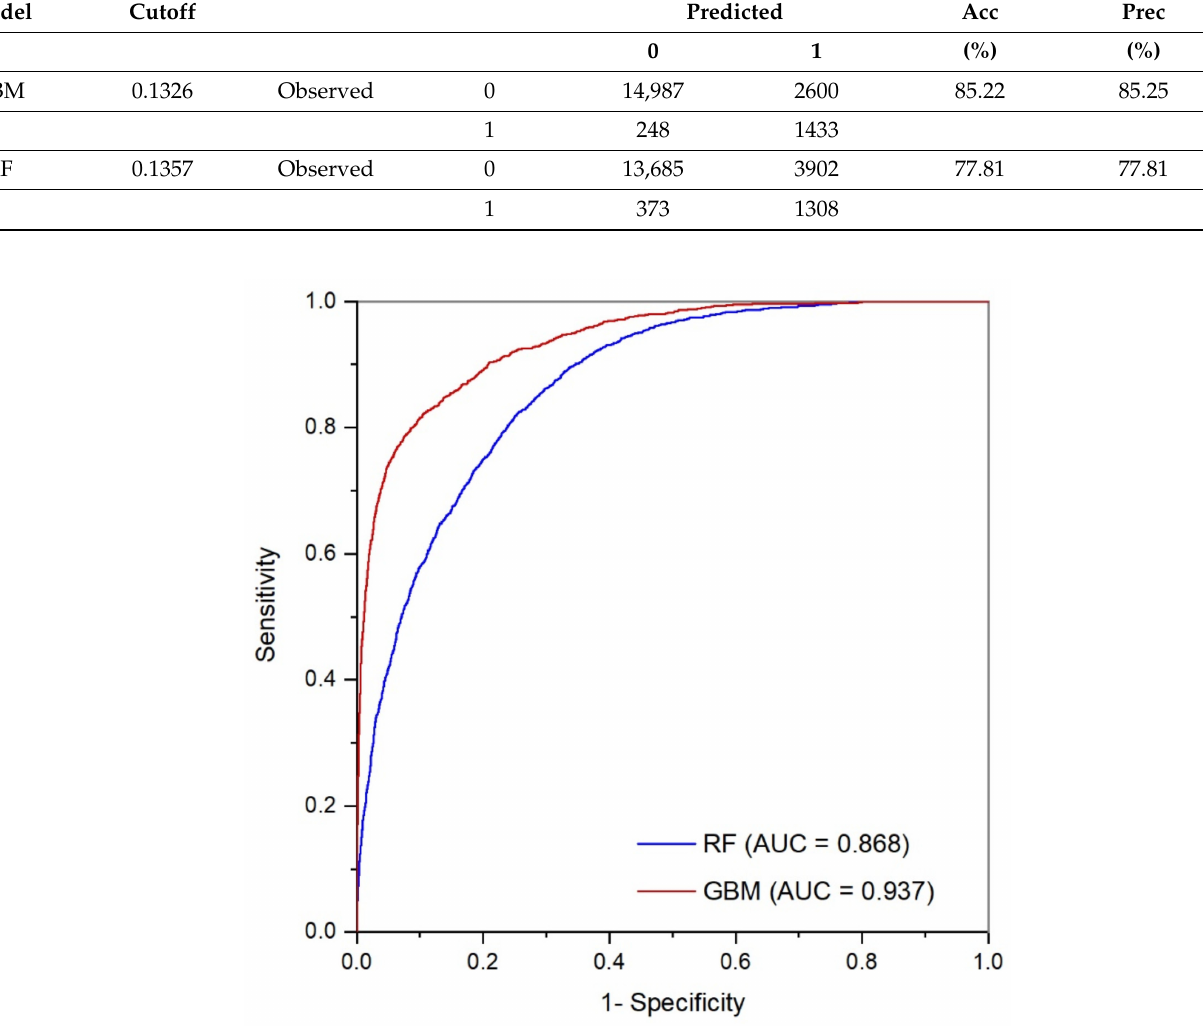
Figure 7. ROC analyses of the GBM and RF models for all fire data in the study